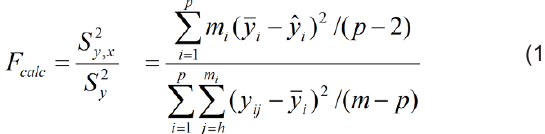
Table 4. Signal replicate values used for FIA regression model implementation.